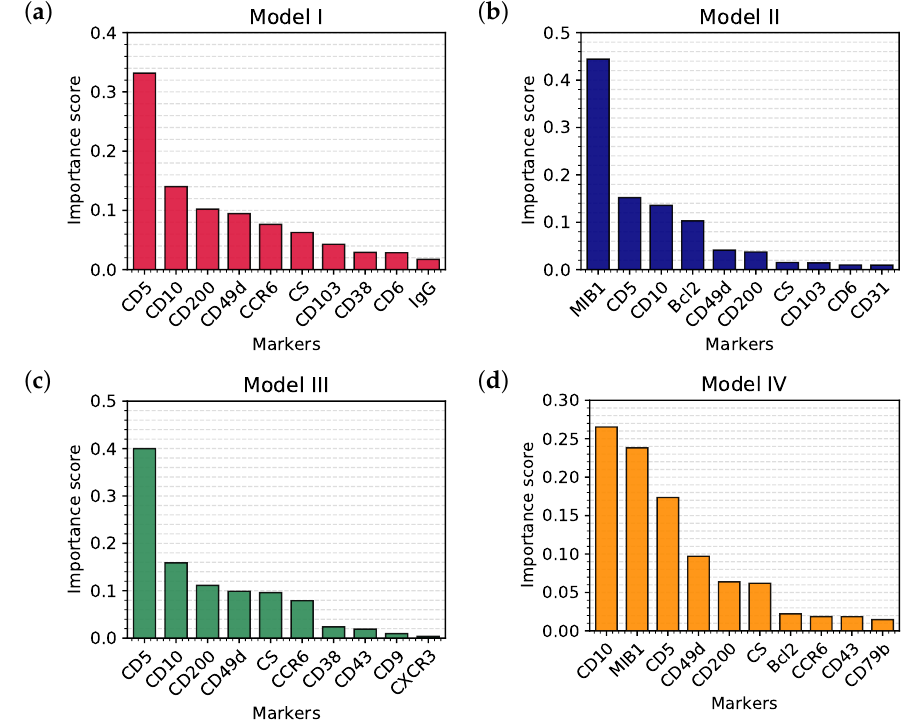
Figure 3. Top 10 markers in order of importance selected by Model I ( a ), Model II ( b ), Model III ( c ), and Model IV ( d ).